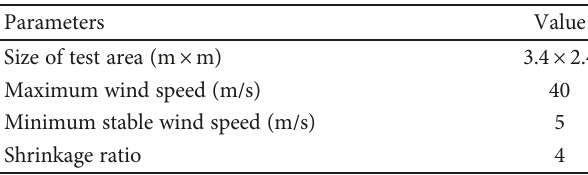
Table 3: Parameters of the wind tunnel.